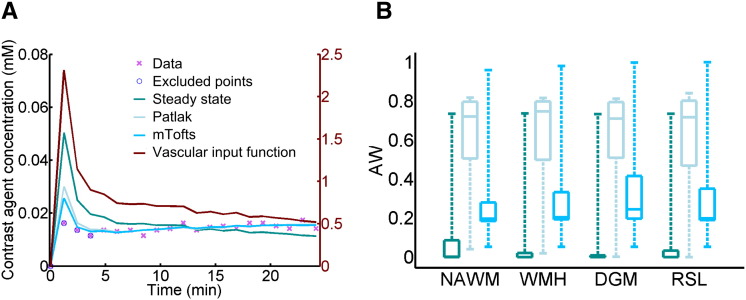
Comparison of model fits to the patient data. (A) Example concentration–time curve for normal-appearing white matter in a single patient. In general, the steady-state model does not fit the data well; while both the Patlak and modified Tofts (mTofts) models typically fit the data similarly well, the Patlak model has a higher Akaike weight (AW) than the modified Tofts model in most cases due to the lower number of free parameters. (B) Comparison of AW for the three models in normal-appearing white matter (NAWM), white matter hyperintensities (WMH), deep grey matter (DGM) and recent stroke lesions (RSL). In most patients, the Patlak model had the highest AW for all tissue types (legend as in A).